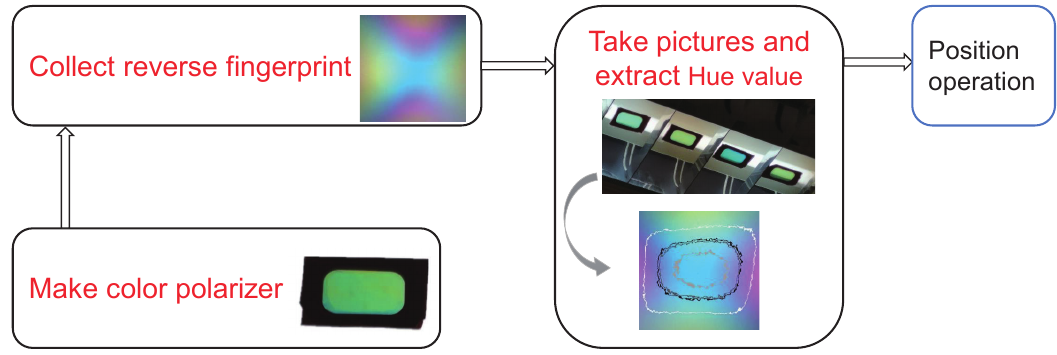
Figure 2. Reverse fingerprint location